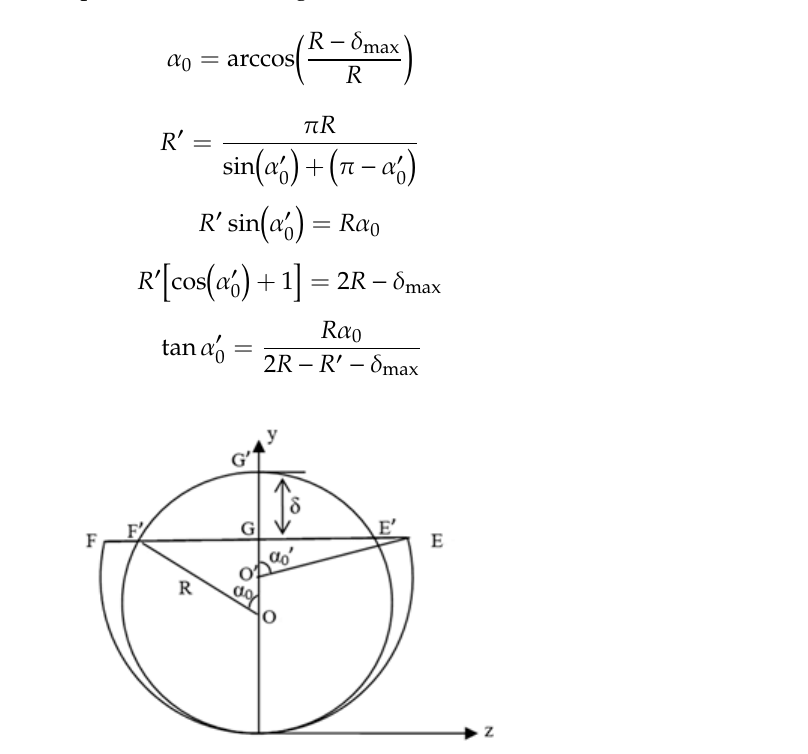
Figure 4. Metal circular tube plastic-deformation zone in the – y direction projection.